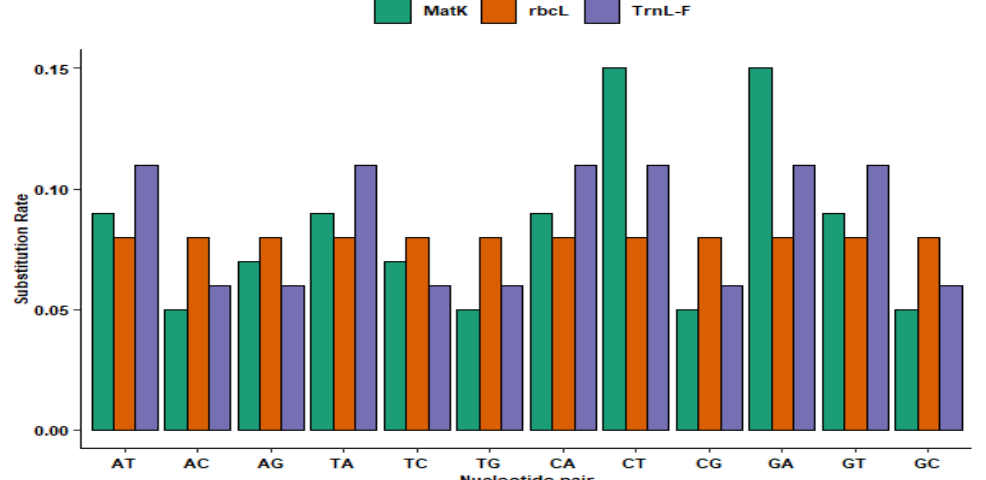
Figure 2. Nucleotide Substitution rates (MatK: Maturase k gene, rbcL: Ribulose biphosphate carboxylase large subunit gene, TrnL-F: TrnL-TrnF intergenic spacer gene, X axis shows substitution of one nucleotide by another in the course of evolution. For instance, AT implies a mutation where Adenine is substituted by Thymine, AC: Adenine being substituted by Cytosine. Y-axis shows the rate at which such substitution can occur. Only 12 possible nucleotide pair substitutions are possible.